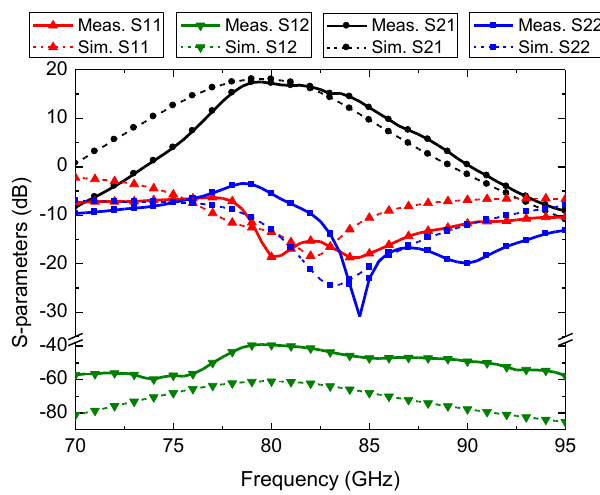
Figure 12. Measured S-parameters of the W-band amplifier.